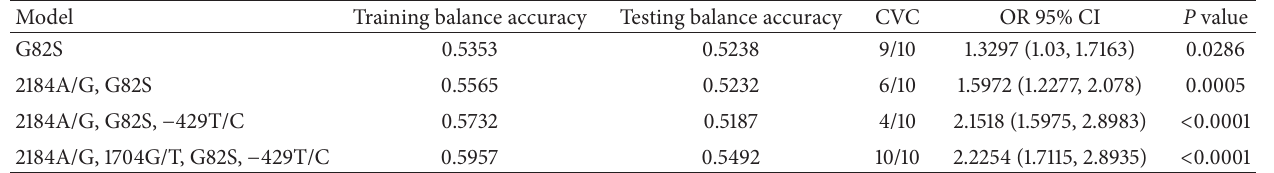
Table 3: Multilocus genetic interaction